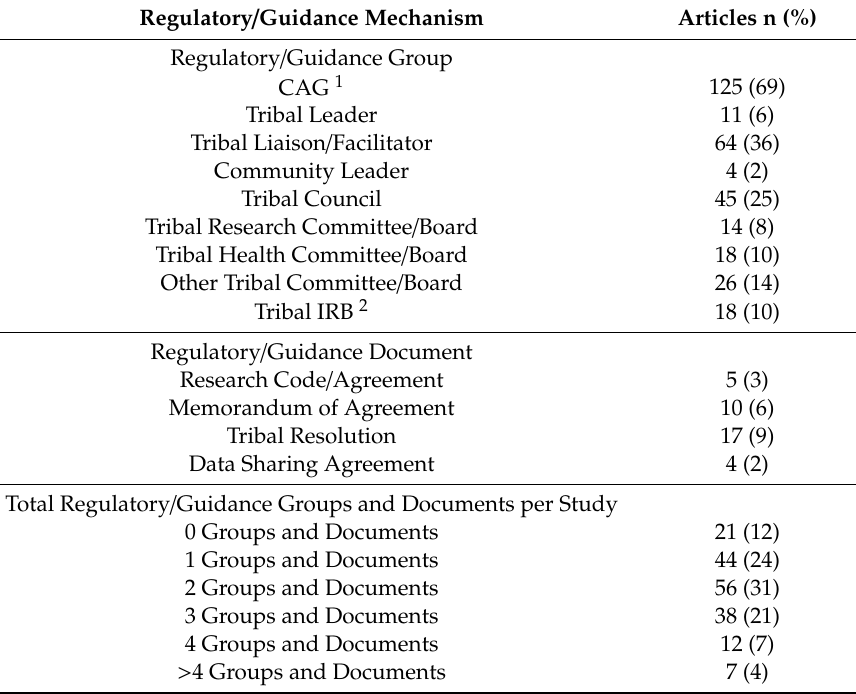
Table 3. Community-Level Mechanisms for Guiding and Regulating